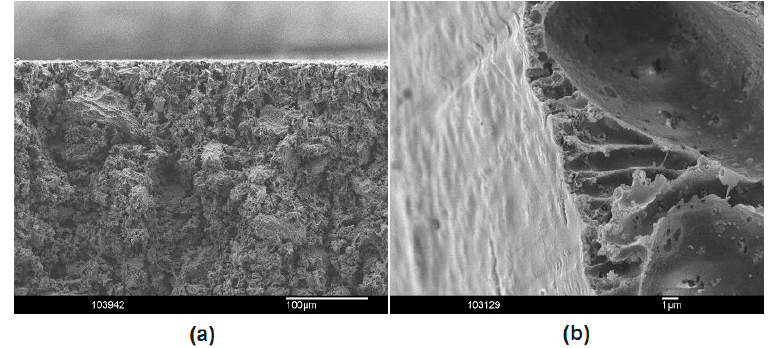
Figure 1. SEM image of the cross-section of a cast AL ( a ) and a cast HGDL ( b ).